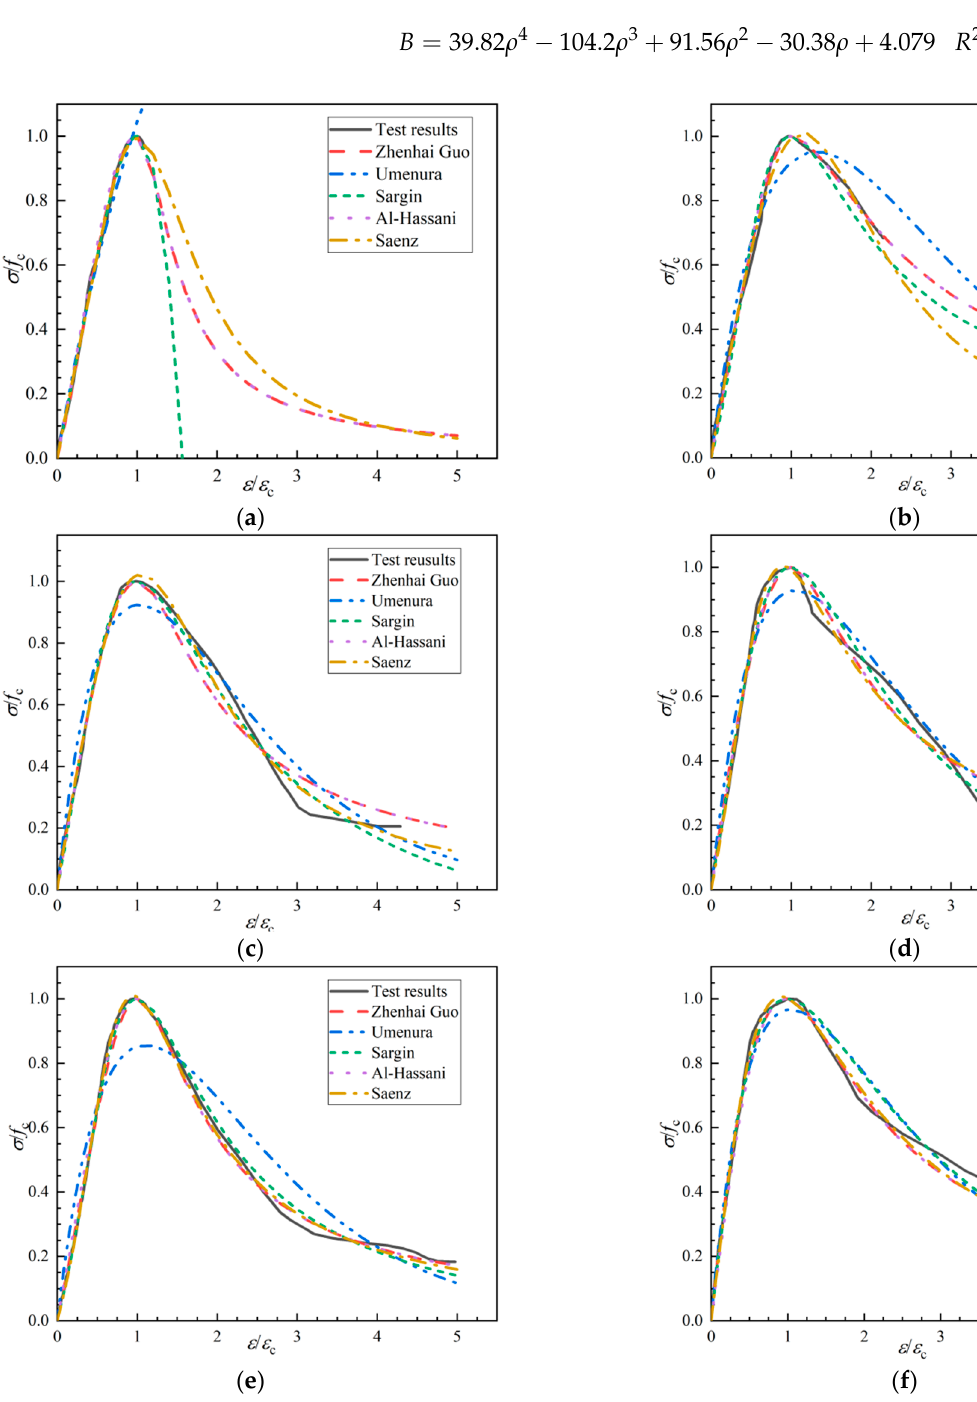
Figure 27. Fitting results of complete stress–strain curves of each group of concrete under axial compression: ( a ) NF; ( b ) POM-0.2; ( c ) POM-0.4; ( d ) POM-0.6; ( e ) POM-0.8; ( f ) POM-1.